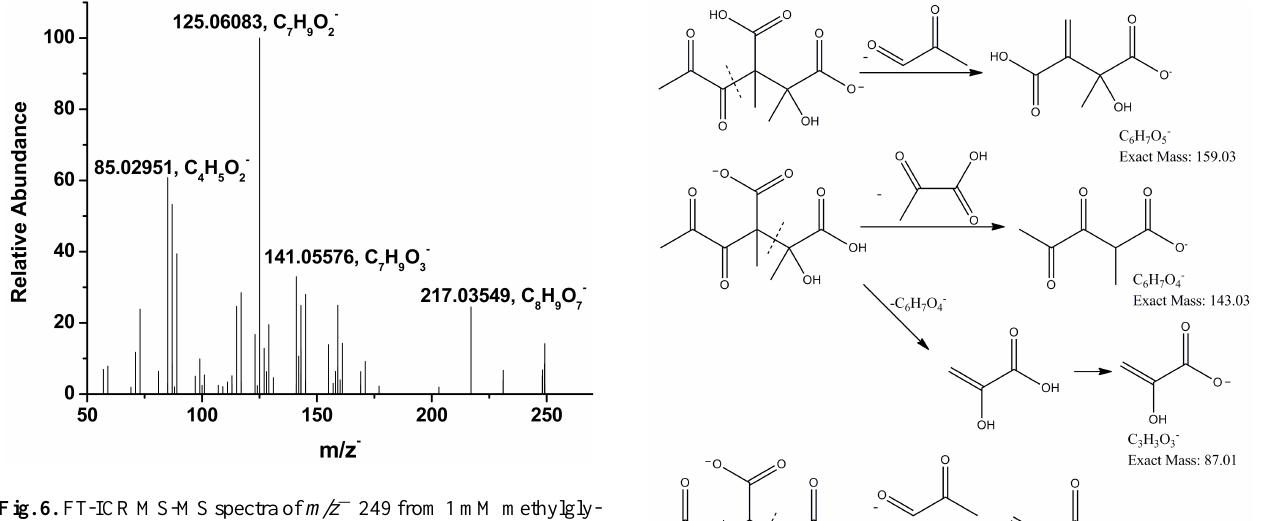
Fig. 6. FT-ICR MS-MS spectra of m/z − 249 from 1mM methylgly- oxal+OH radical experiment (76min reaction